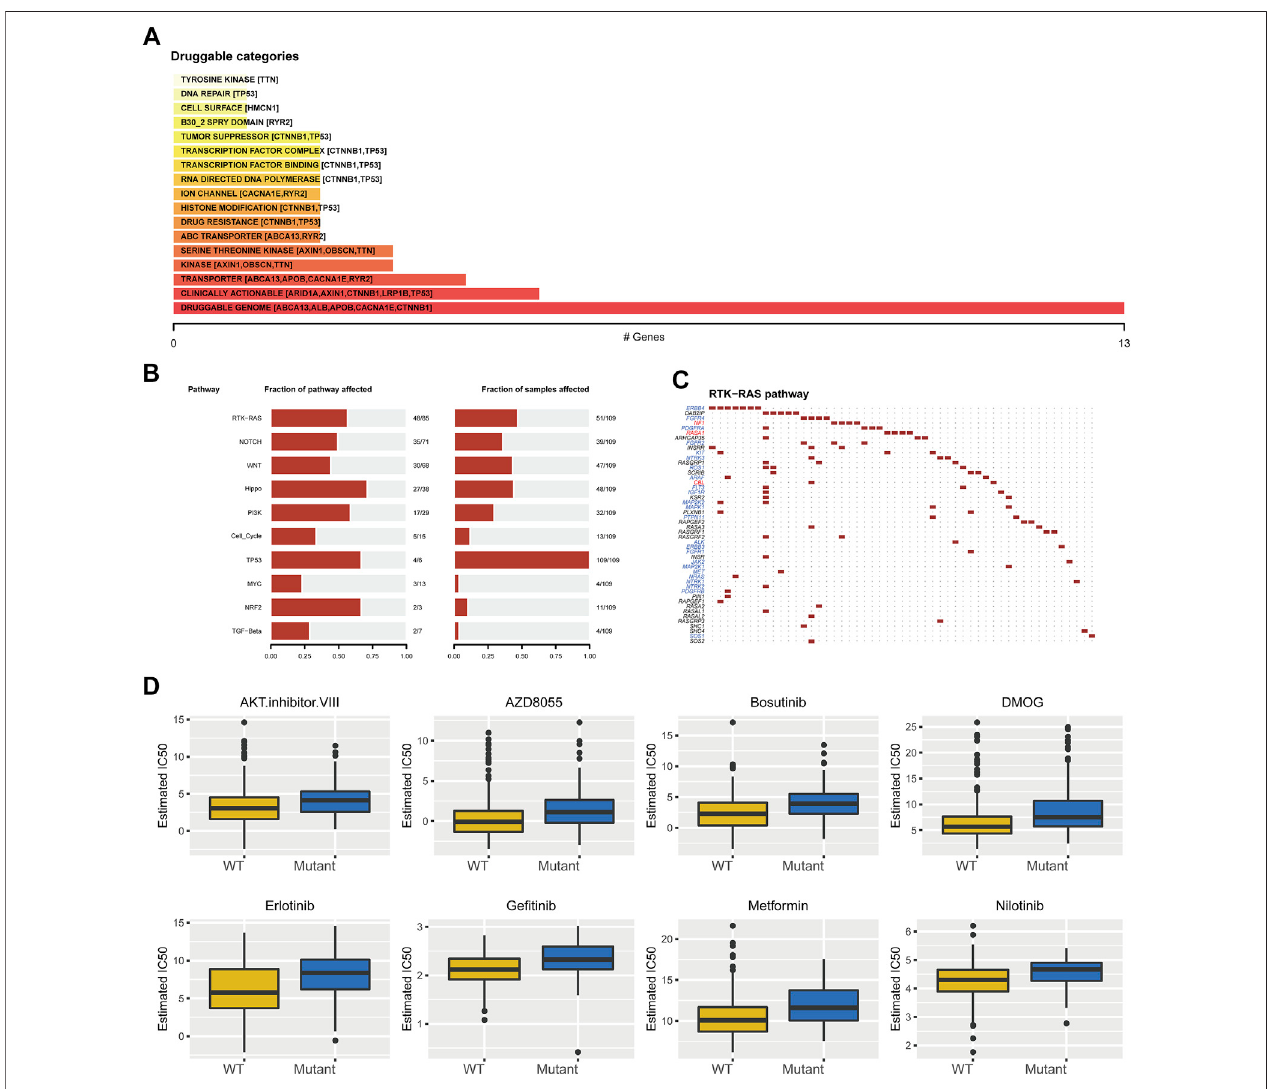
FIGURE 3 | Drug sensitivity analysis of TP53 gene mutation. (A) : The relationship between gene mutation level in TCGA-LIHC and different kinds of drugs. (B) : Changesofgenemutationlevelsindifferentcarcinogenicsignalpathways. (C) :MutationdistributionofmaingenesinRTK-Rassignalingpathway. (D) :SensitivityofTP53 mutation to different chemotherapeutics and small molecule anticancer